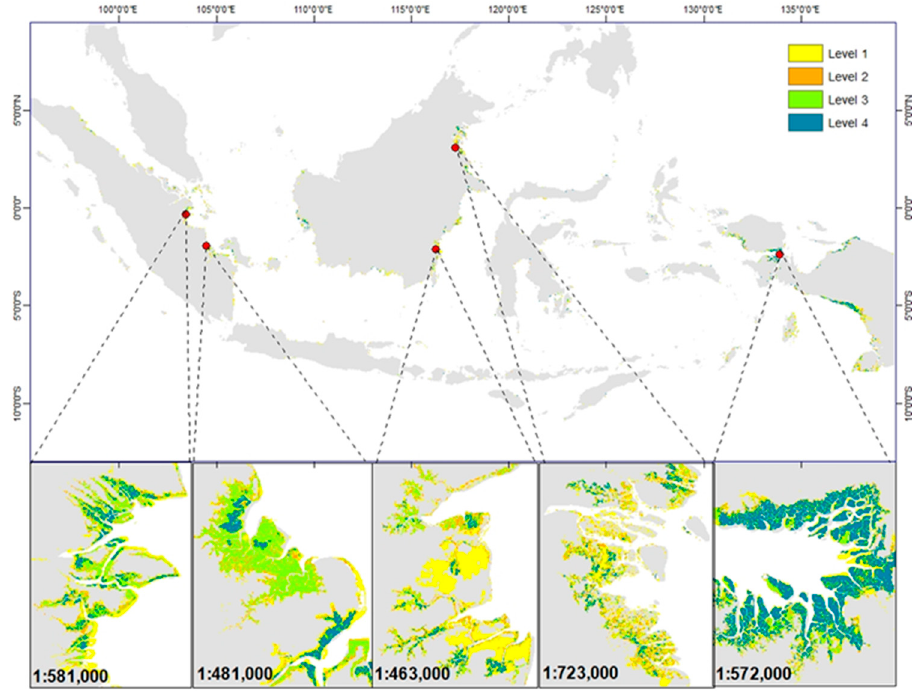
Figure 11. Agreement level of mangrove distribution in Indonesia. Remote Sens. 2020 , 12 , 2720